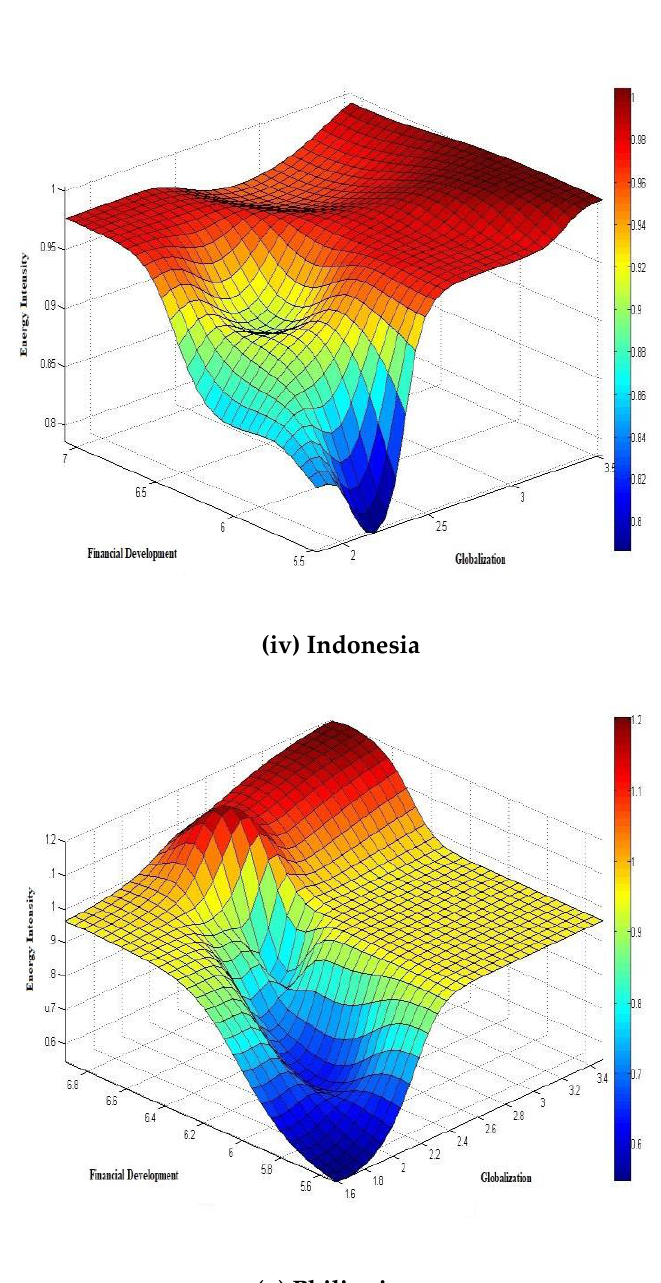
Figure 3. Energy Intensity prediction based on Globalization and Financial Development of Top 5 ASEAN Countries. Note: The X−axis represents the globalization index, the Y−axis shows financial development, and the Z−axis specifies energy intensity. Moreover, the blue colour shows the low magnitude, and the red colour describes the high magnitude of the relationship between the variables.